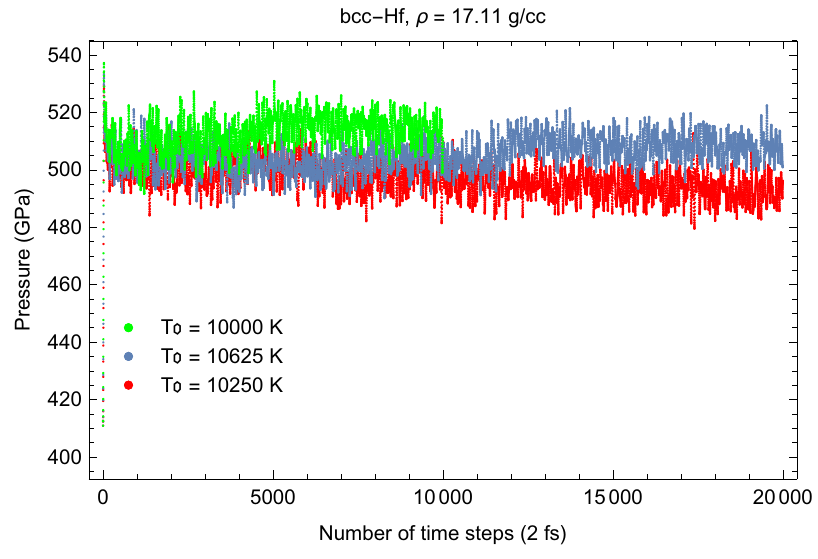
Figure 18. The same as in Fig. 17 for the time evolution of P .